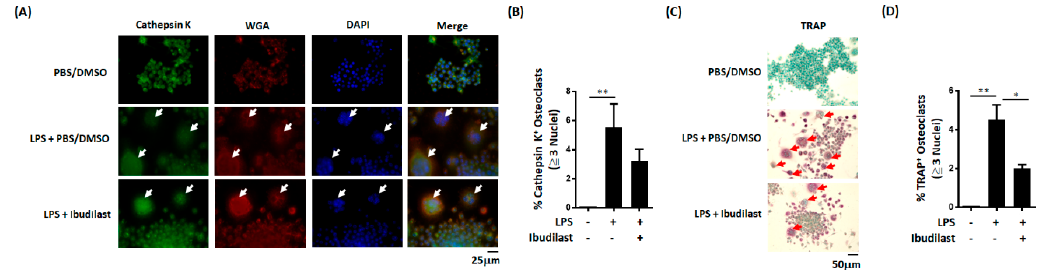
Figure 4. Ibudilast inhibits LPS-induced osteoclast differentiation in vitro. ( A ) Representative image illustrating the inhibitory effect of ibudilast on the differentiation of cathepsin K-positive osteoclasts. RAW264.7 cells were cultured for 5 days with LPS (100 ng/mL) in the presence of ibudilast (10 μ M) and subsequently stained for cathepsin K. ( B ) Quantitative data analysis confirmed the inhibitory effect of ibudilast against the formation of cathepsin K-positive multinucleated ( ≥ 3 nuclei) cells in vitro. ( C ) Representative image illustrating the inhibitory effect of ibudilast on the differentiation of TRAP-positive osteoclasts. ( D ) Quantitative data analysis confirmed the inhibitory effect of ibudilast against the formation of TRAP-positive multinucleated ( ≥ 3 nuclei) cells in vitro. Data are presented as means ± standard errors of the mean. Analyses were conducted with unpaired Student’s t -tests. * p < 0.05, ** p < 0.01. LPS, lipopolysaccharide; TRAP, tartrate-resistant acid phosphatase.